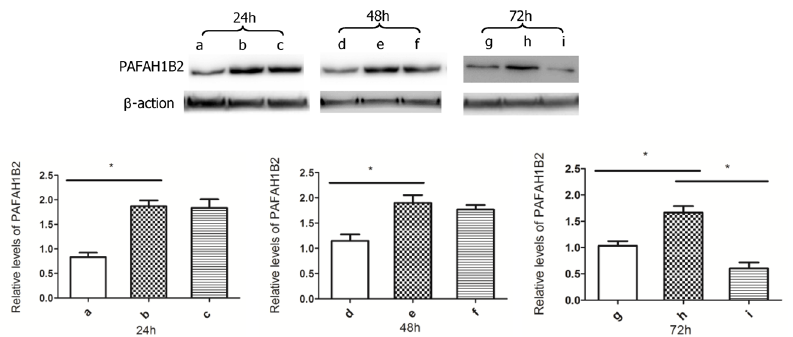
Fig 5. The expression of PAFAH1B2 in H7N9 infection. The a , d and g were the relative levels of PAFAH1B2 in primary A549 cells. The b , e and h were the relative levels of PAFAH1B2 in A549 cells with recombinant plasmid. The c , f and i were the relative levels of PAFAH1B2 in A549 cells with recombinant plasmid infected by H7N9 virus at 24,48 and 72hpi. The date are shown the relative levels of PAFAH1B2 with SD (n = 3, * p <